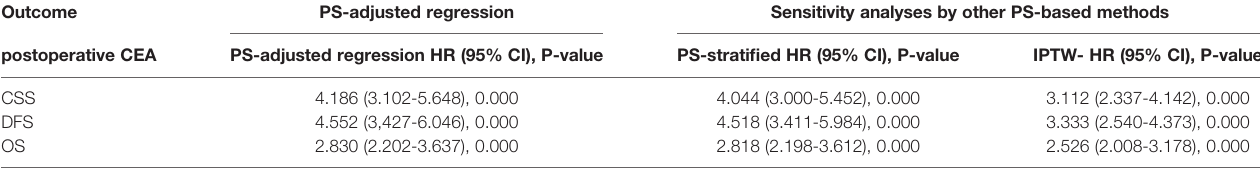
TABLE 4 | Cox regression analysis after PS-adjusted.